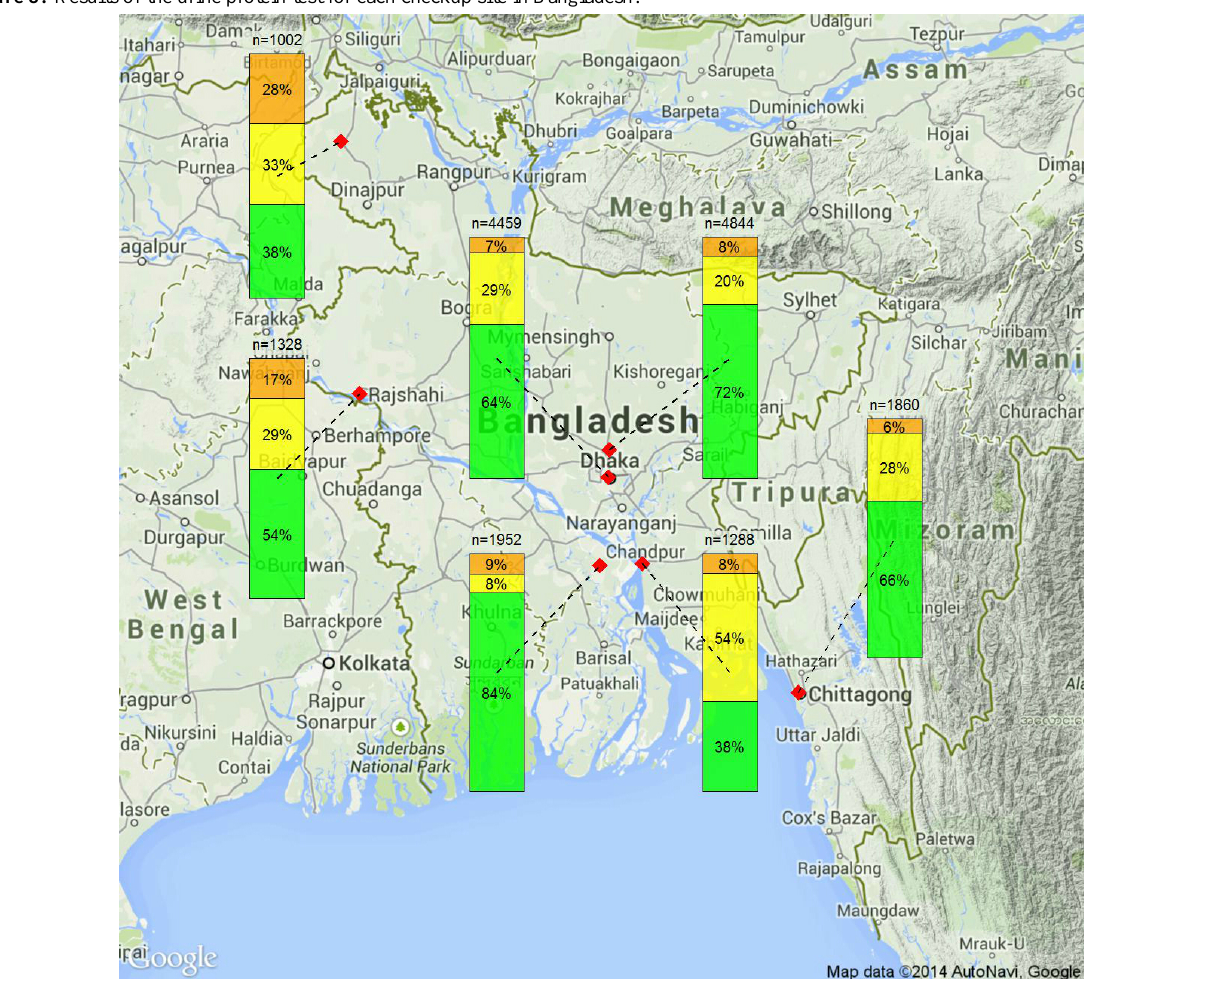
Figure 8. Results of the urine protein test for each checkup site in